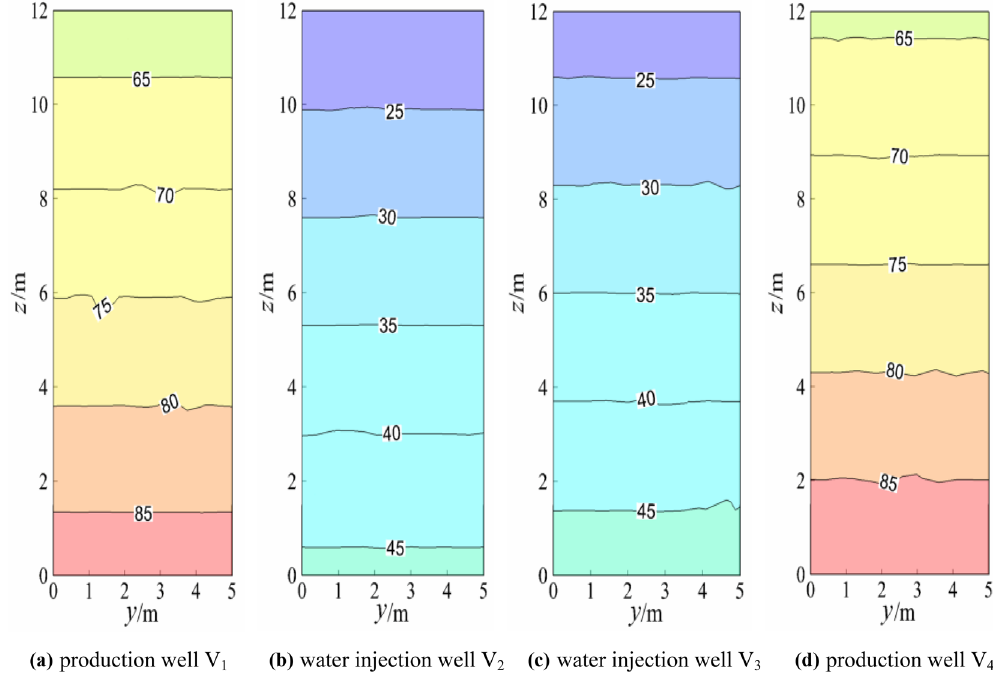
Figure 6. Temperature field ofthegeothermal well plane (working condition